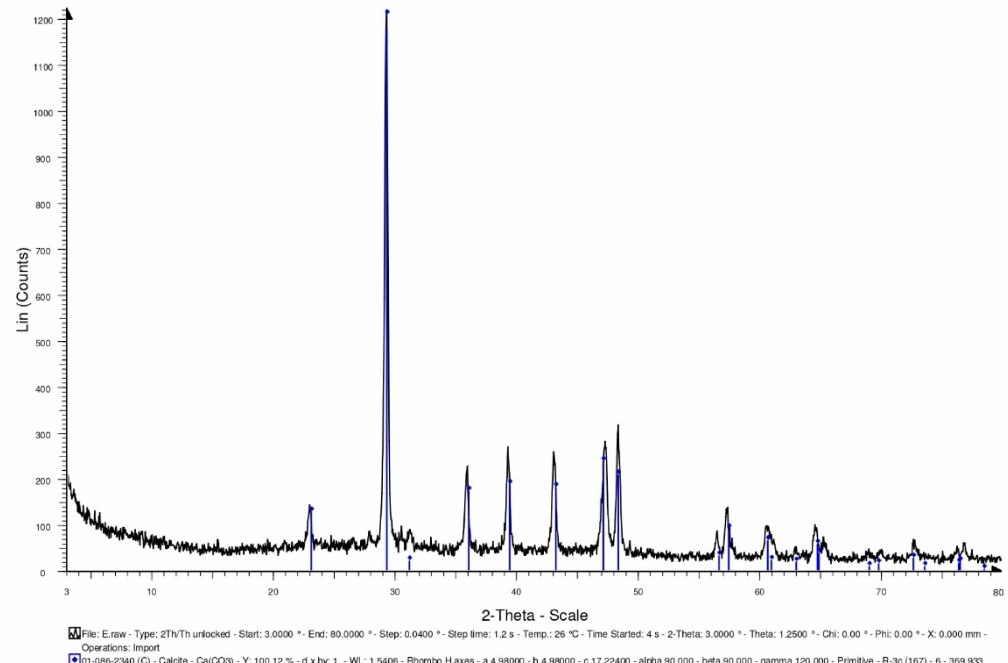
Figure 10. XRD-analysis results of the bacteria powders subjected to high temperature (using lightweight aggregates as a